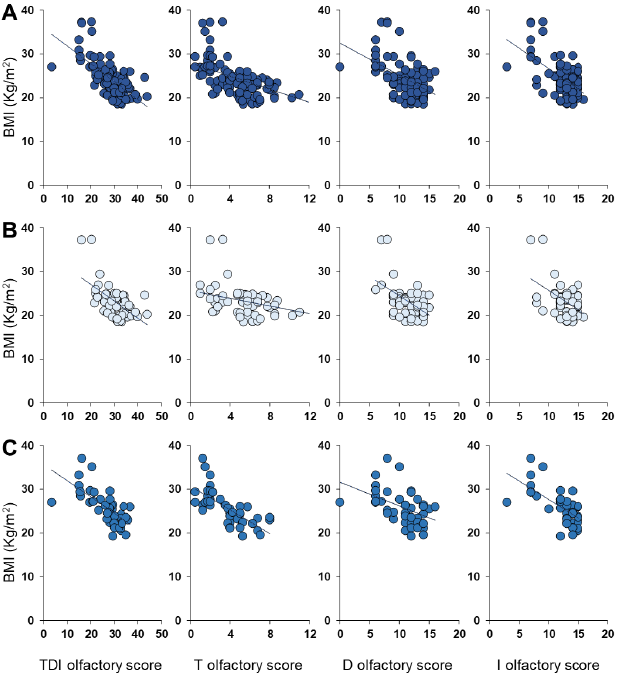
Figure 5. Correlation analysis between BMIs and TDI, T, D and I olfactory scores obtained by indi- viduals of both sexes together ( A ), only females ( B ) or only males ( C ).